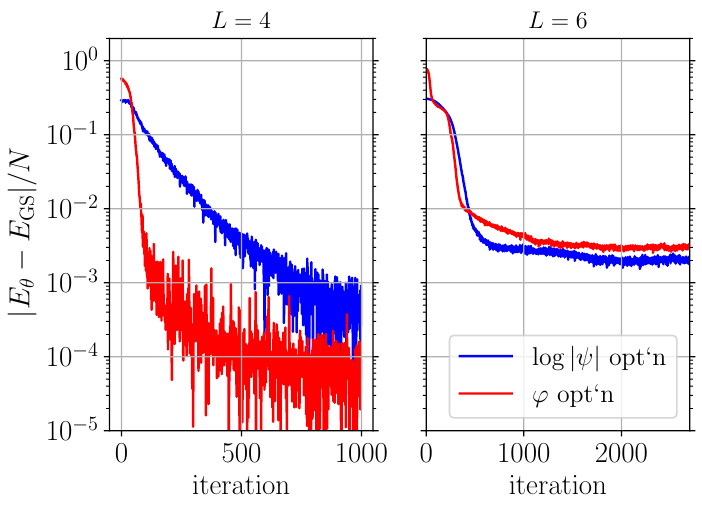
Figure 8: Energy minimization in the partial learning problem for N = 4 × 4 (left panel) and N = 6 × 6 (right panel): ln | ψ | -optimization (blue) shows the ampli- tude learning curves for the log-amplitude network, using the sign structure of the exact ground-state at every iteration step (i.e., we do not use a phase network). ϕ - optimization (red) shows the phase learning curves for the phase network, using the amplitudes of the exact ground state at every iterations step (i.e., we do not use a log- / J = 0.5. amplitude network). The network architecture is listed in App. H, and J 2 1 Optimization was done using RK in combination with SR, see App. A. The MC sample = 2 10 for N = 4 × 4, and N = 2 15 for N = 6 × sizes are N MC MC